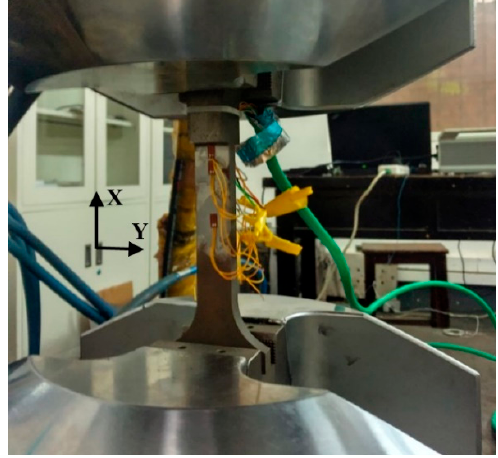
Figure 4. The arrangement of strain gauge on the specimen.